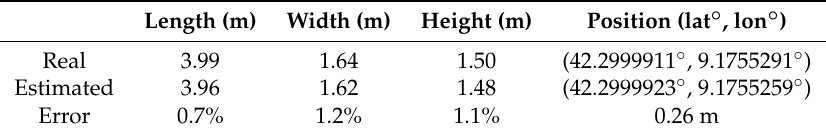
Table 1. Comparison between real and estimated measurements of the car.